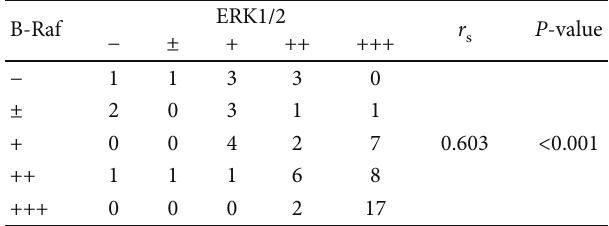
Table 6: The relationship between B-Raf and ERK1/2 protein expression in colon cancer tissue.